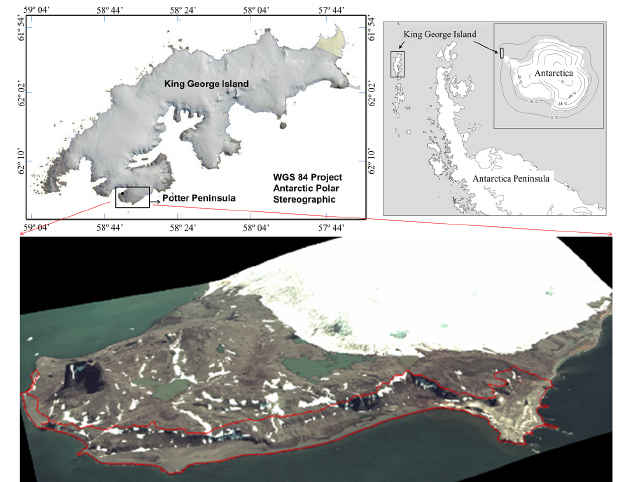
Figure 1. Top left: localization map of Potter Peninsula in the mar- itime Antarctica. Top right: location in relation to Antarctic Penin- sula. Bottom: Quickbird 2 image in perspective view. The red line shows the limit of ASPA